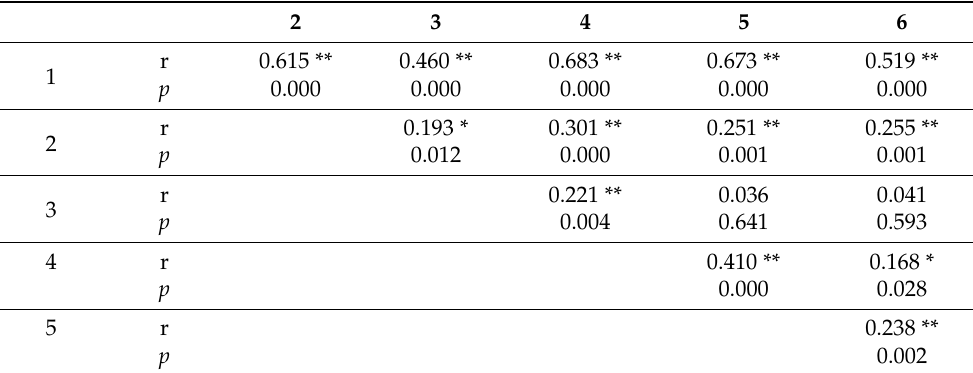
Table 3. Correlations between SOTG domains scores for U17 division ( n = 170).